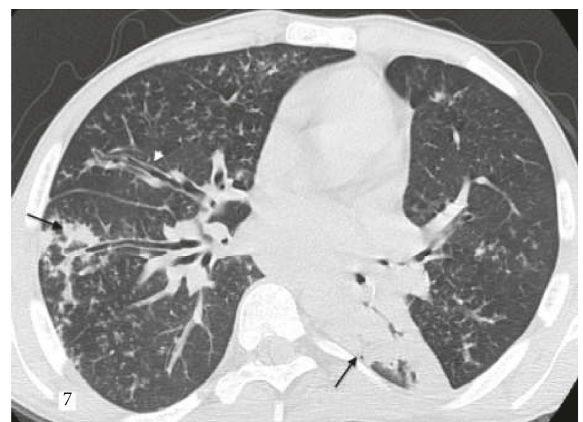
Figure 7: A 24-year-old male patient diagnosed with known primary immunodeficiency with adenovirus pneumonia. According to the RSNA guidelines “undetermined,” CORADS score given as 4. Irregular peripheral consolidation (black arrows) and increased peribronchial thickness (white arrowhead) are